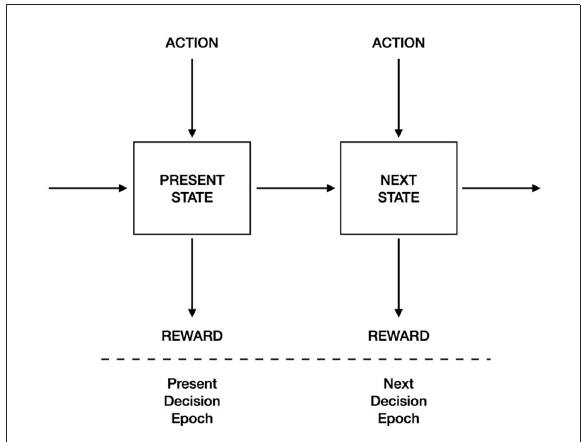
FIGURE2 Schematic representation of a Sequential Decision